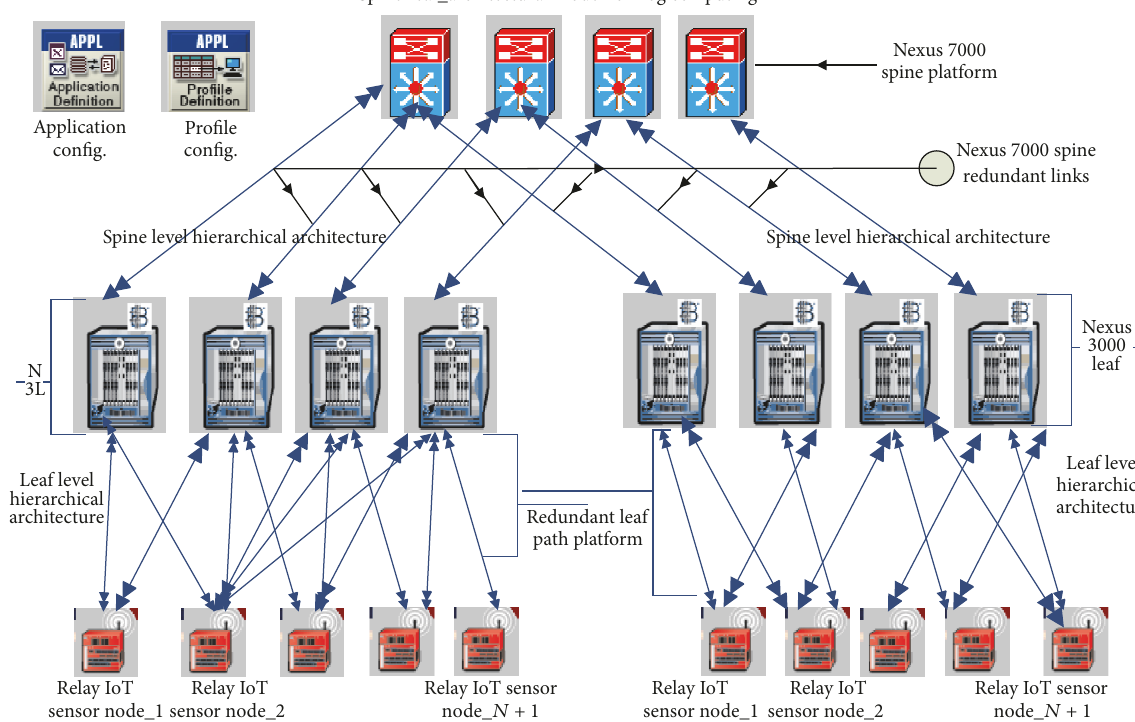
Figure 3: Design of Fog computing datacenter using Cisco Nexus